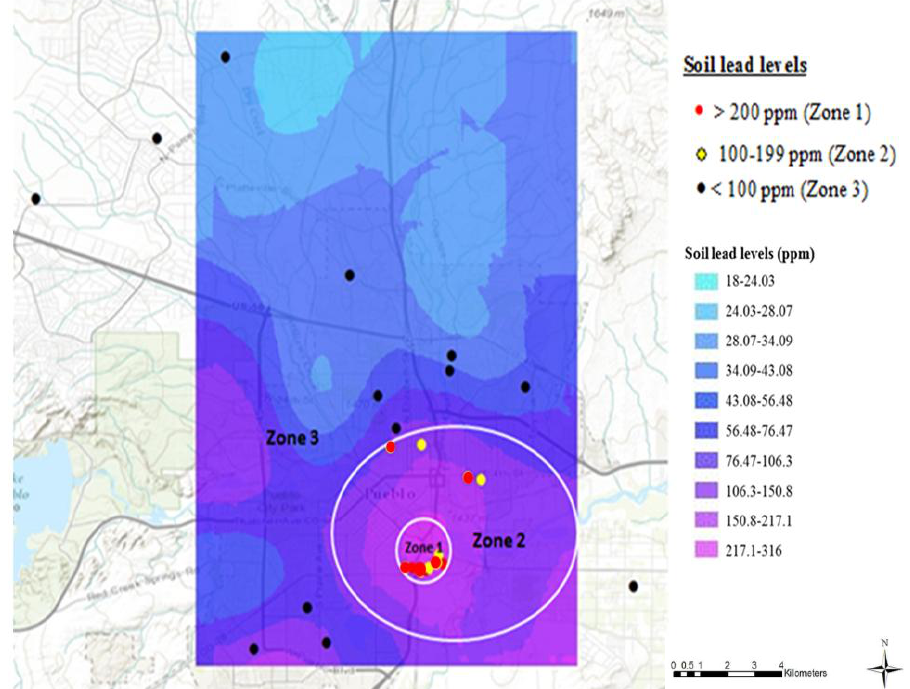
Figure 1. Categorization of Pueblo, Colorado based on topsoil sampling conducted during the current study in 2013 and re-constructed prediction map from previously reported topsoil lead levels